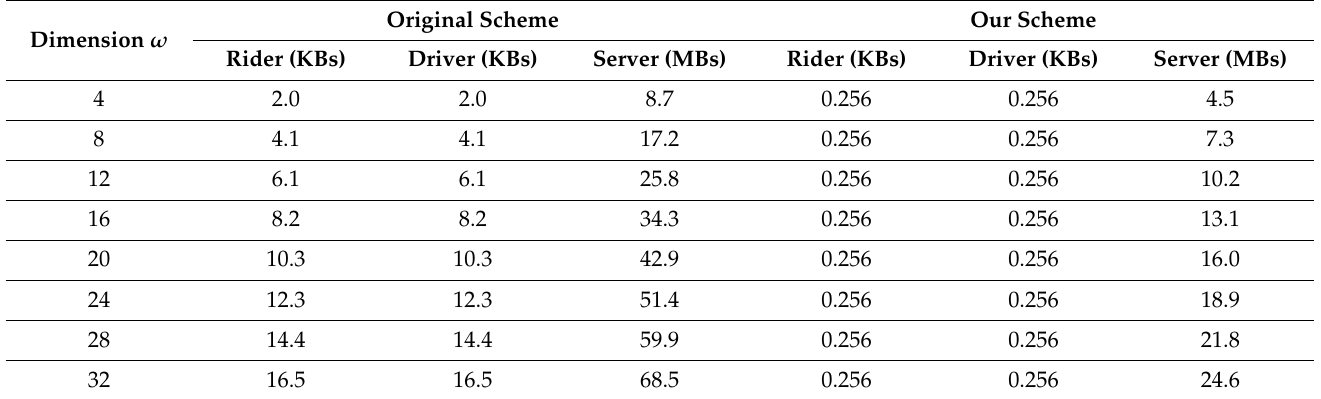
Table 3. Communication overhead and computation cost.